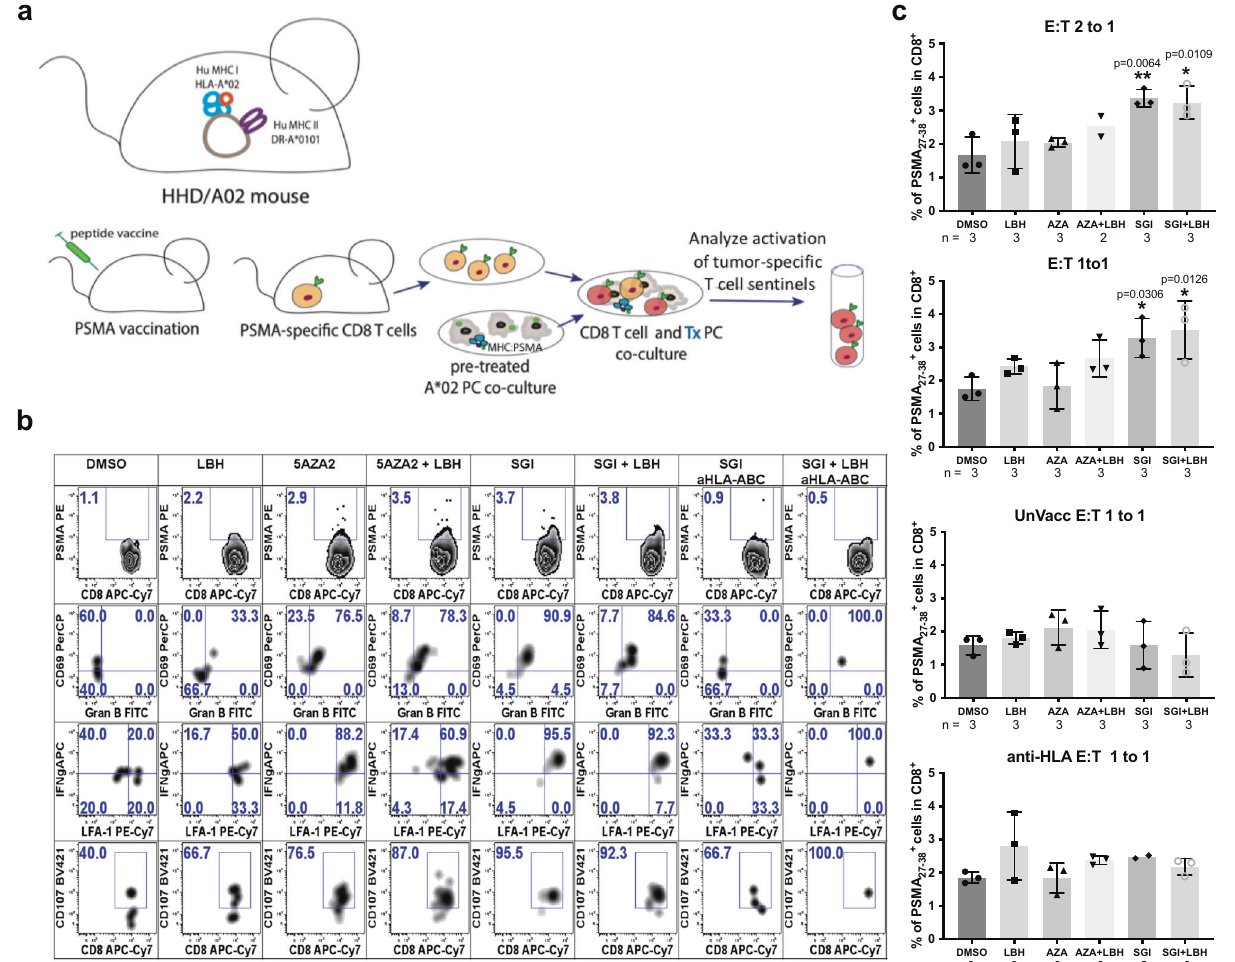
Fig. 6 DNMT and HDAC inhibition in tumor cells increase co-cultured T-cell activation. a Vaccination and co-culture scheme to analyze PSMA 27-38 - speci fi c T-cell response to LNCaP cells treated with epigenetic modifying agents. b Plots represent the rare-event cell analysis of PSMA 27-38 -speci fi c T-cells to assess the cytolytic features. Top row shows PSMA 27-38 tetramer binding on the total CD8 + splenocyte subset. PSMA 27-38 tetramer + cells are projected in rows 2 – 4 and gate frequencies are expressed as a percentage of total PSMA 27-38 CD8 + T-cells. Plots represent expression of activation markers CD69, LFA-1, IFN γ , granzyme B, and CD107 (LAMP1). c Graphs represent the frequency of PSMA 27-38 pentamer positive cells within the total CD8 + T-cell population after co-culture with LNCaP cells treated with epigenetic modifying agents. Splenocytes were co-cultured with LNCaPs in ratios of 2:1 and 1:1 PSMA 27-38 tetramer + CD8 + T-cell Effector to tumor Target (E:T). In control conditions, splenocytes from unvaccinated mice were co-cultured